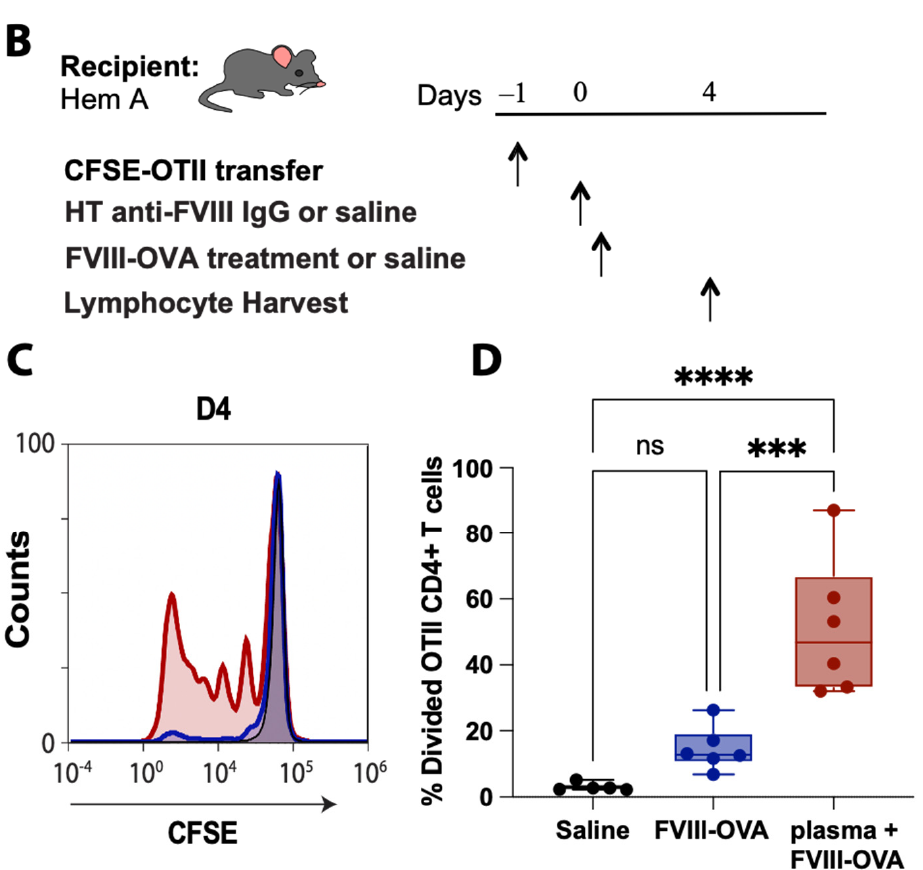
Figure 5. FVIII-OVA induces OTII CD4 T cell proliferation following passive immunization with plasma containing anti-FVIII IgG. ( A ) Hemophilia A mice received 5 weekly injections of rFVIII, followed by serum collection and ELISA to detect anti-FVIII IgG. ( B ) Hemophilia A mice were adoptively transferred with 10 × 10 6 CFSE-labeled OTII splenocytes. Twenty-four hours later, mice were infused with either saline, 2 µ g FVIII-OVA, or 200 µ L pooled high-titer (HT) serum plus 2 µ g FVIII-OVA 2–4 h later. Lymphocytes were isolated 4 days later and assessed by flow cytometry. Representative histogram ( C ) and quantification ( D ) of OTII CD4 T cell proliferation in mice treated with saline (black), FVIII-OVA (blue) and HT plasma plus FVIII-OVA (red). Error bars represent standard deviation, **** = p < 0.0001, *** = p < 0.0007; 1-way ANOVA with Tukey’s post hoc test. HT = high-titer, D4 = day 4; ns = not significant.